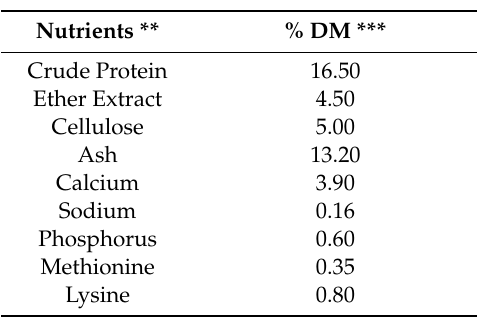
Table 1. Chemical composition of the diet.